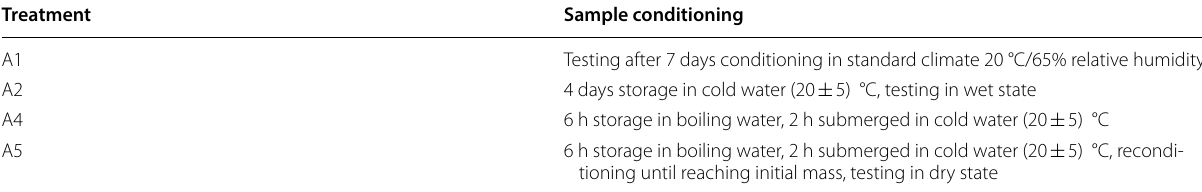
Table 3 Definitions of sample treatment for tensile shear strength according to EN 302-1 [21] Treatment Sample